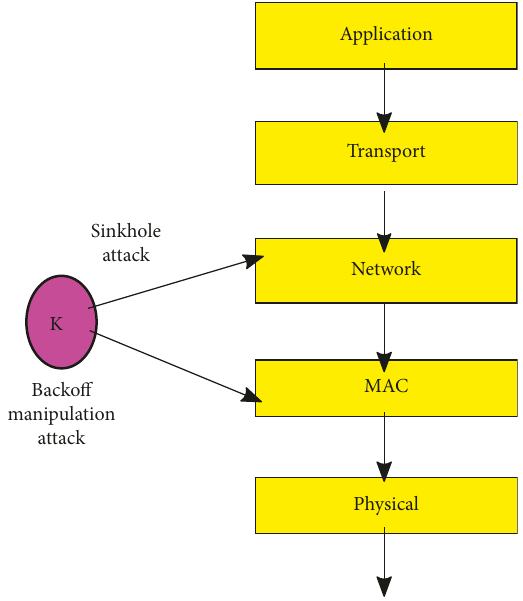
Figure 6: Cross-layer attack at the protocol layer.